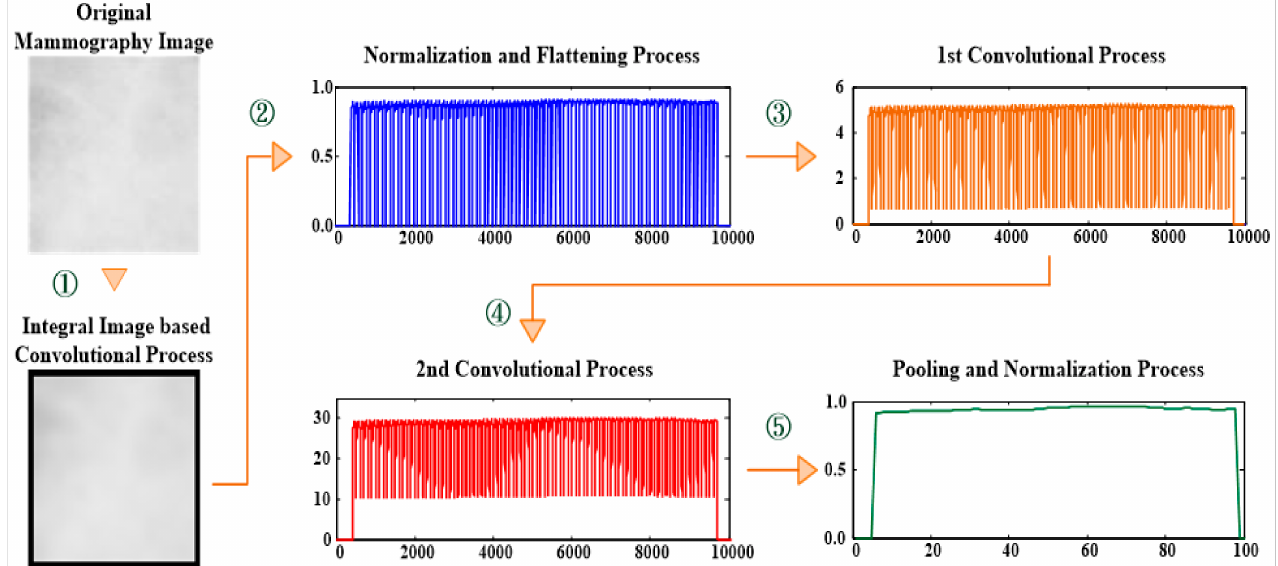
Figure 5. Image enhancement and feature extraction with the integral image-based convolutional process ( 1 (cid:13) ), normalization and flattening process ( 2 (cid:13) ), two-round 1D convolutional processes ( 3 (cid:13) and 4 (cid:13) ), and pooling and normalization processes ( 5 (cid:13)